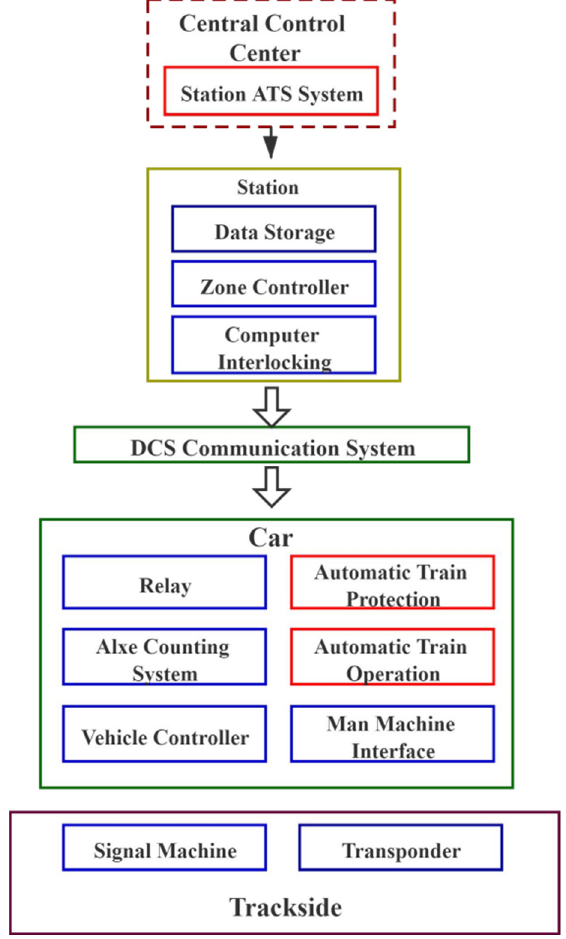
Figure 1. The structure of the CBTC system.